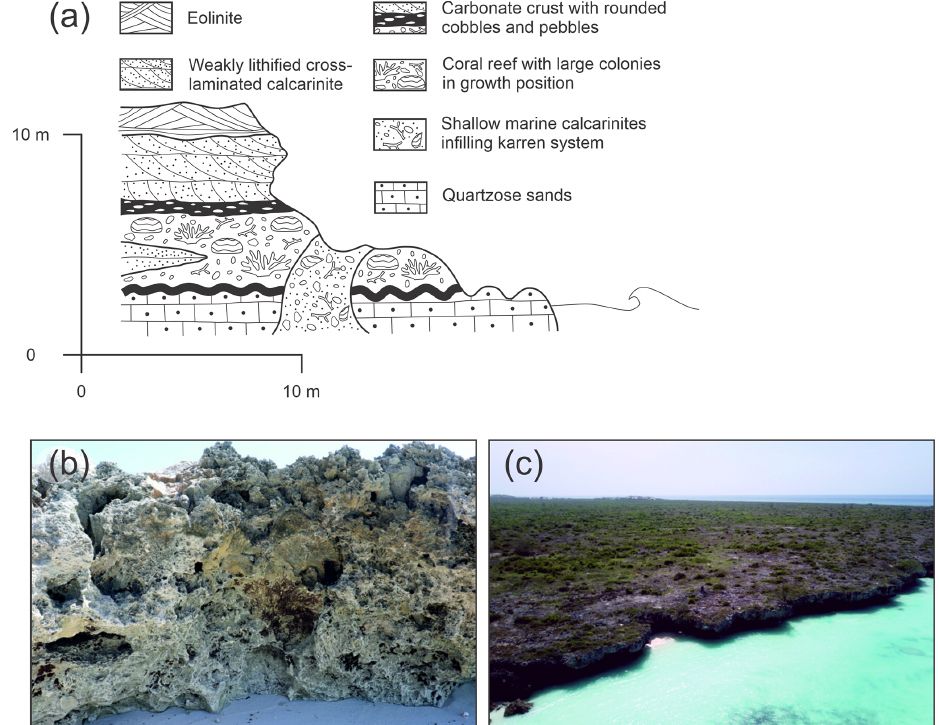
Figure 7. (a) Litholog of Marine Terrace II (modified after Korotky et al., 1992). (b) Lower part of the Pleistocene reef complex at Aldabra. (c) Aerial view of the Pleistocene reef at Assumption Island. Photos by Alessio Rovere.